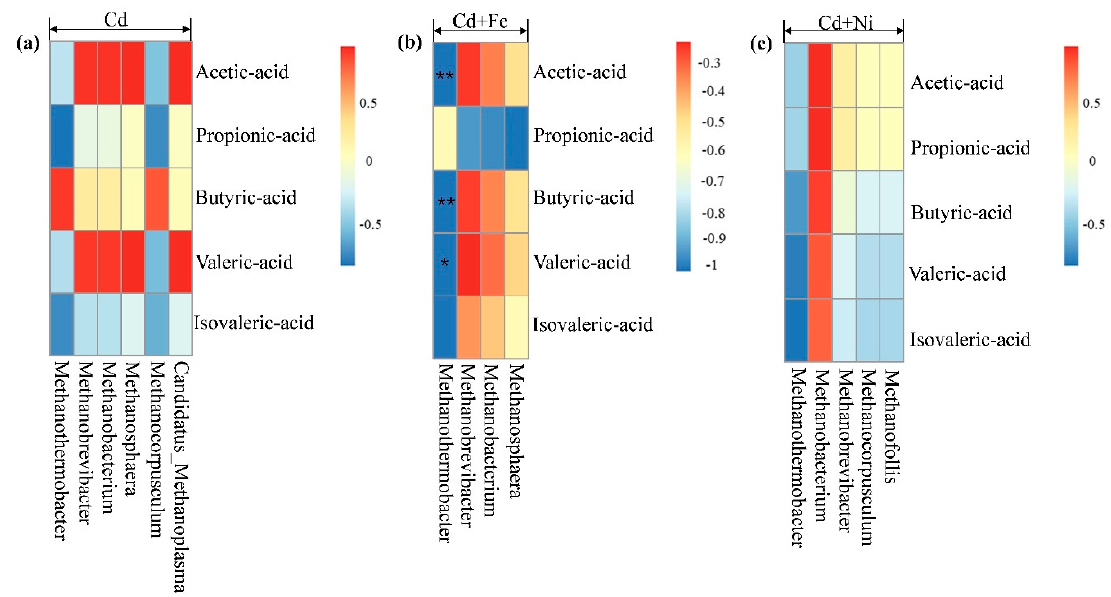
Figure 9. Pearson correlation analysis between VFA components and methanogen under Cd ( a ), Cd + Fe ( b ), and Cd + Ni ( c ) addition during the fermentation.